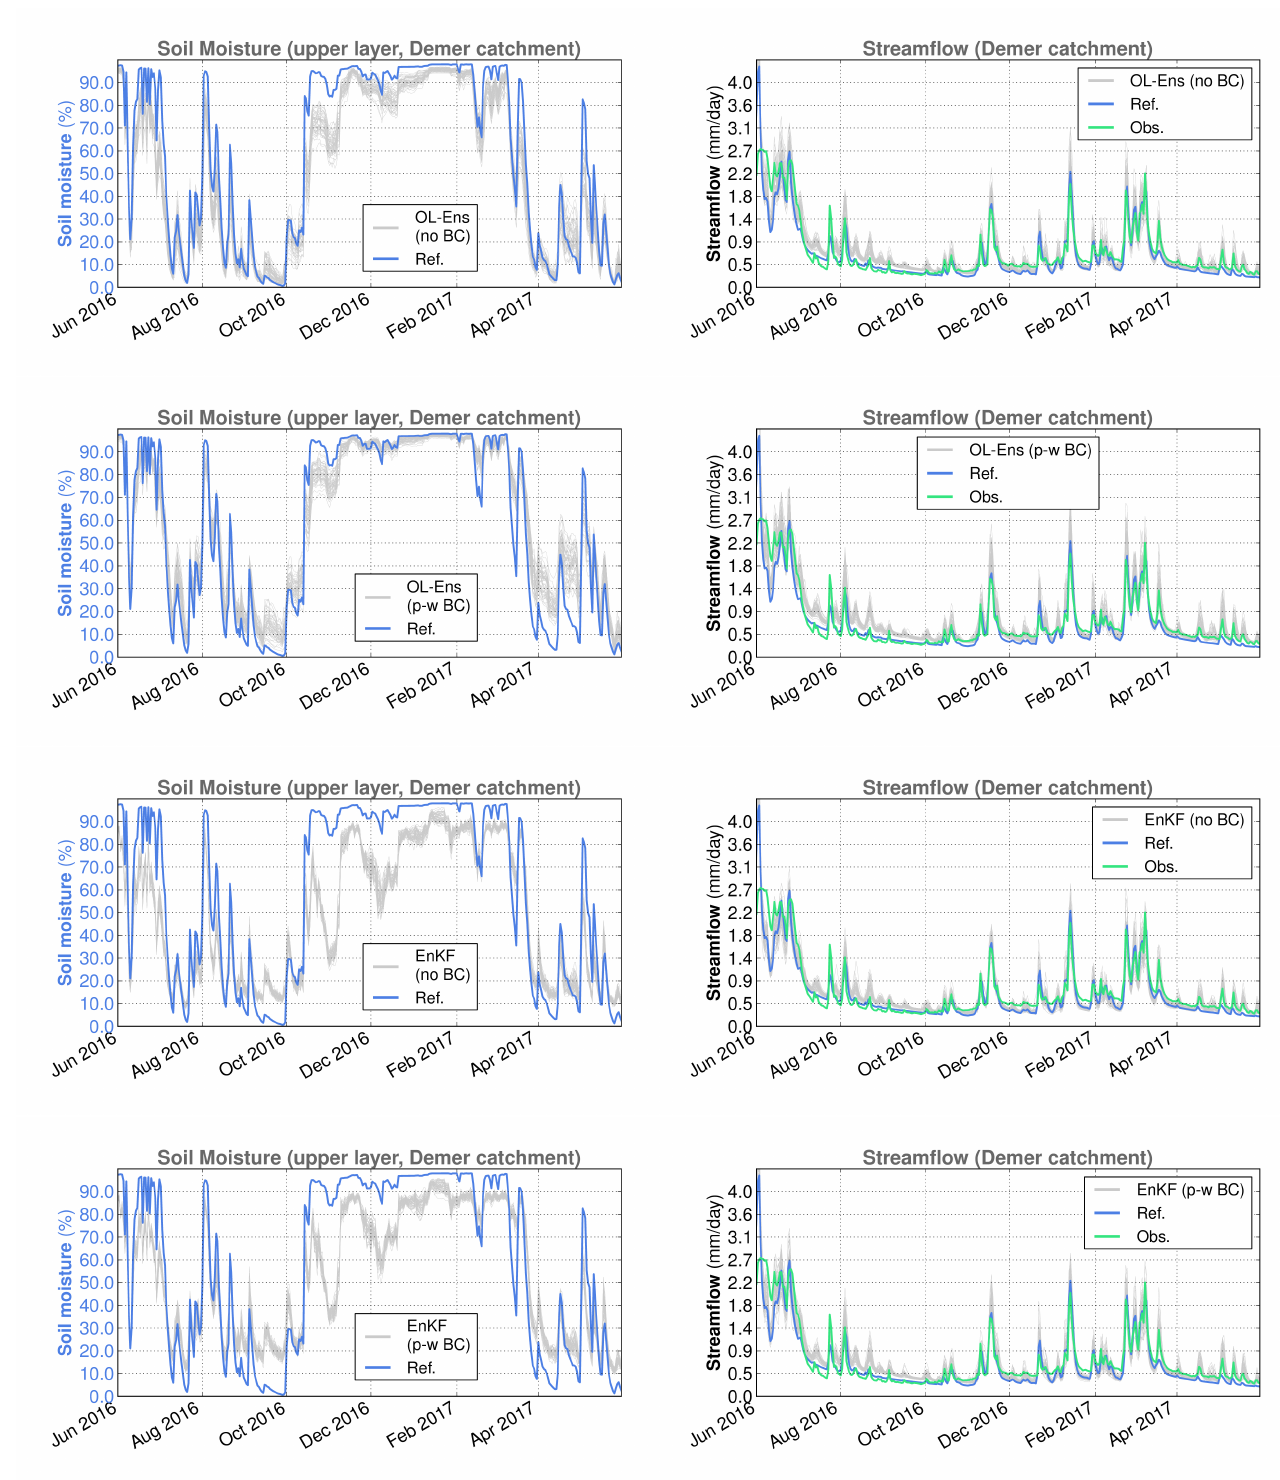
Figure 8. Spatially averaged surface soil moisture (reference simulation and ensemble members) and streamflow (reference simulation, observations and ensemble members) for the Demer catch- ment in SCHEME model simulations, June 2016–May 2017. From top to bottom: OL without bias correction, OL with piece-wise bias correction, EnKF without bias correction, EnKF with piece-wise bias